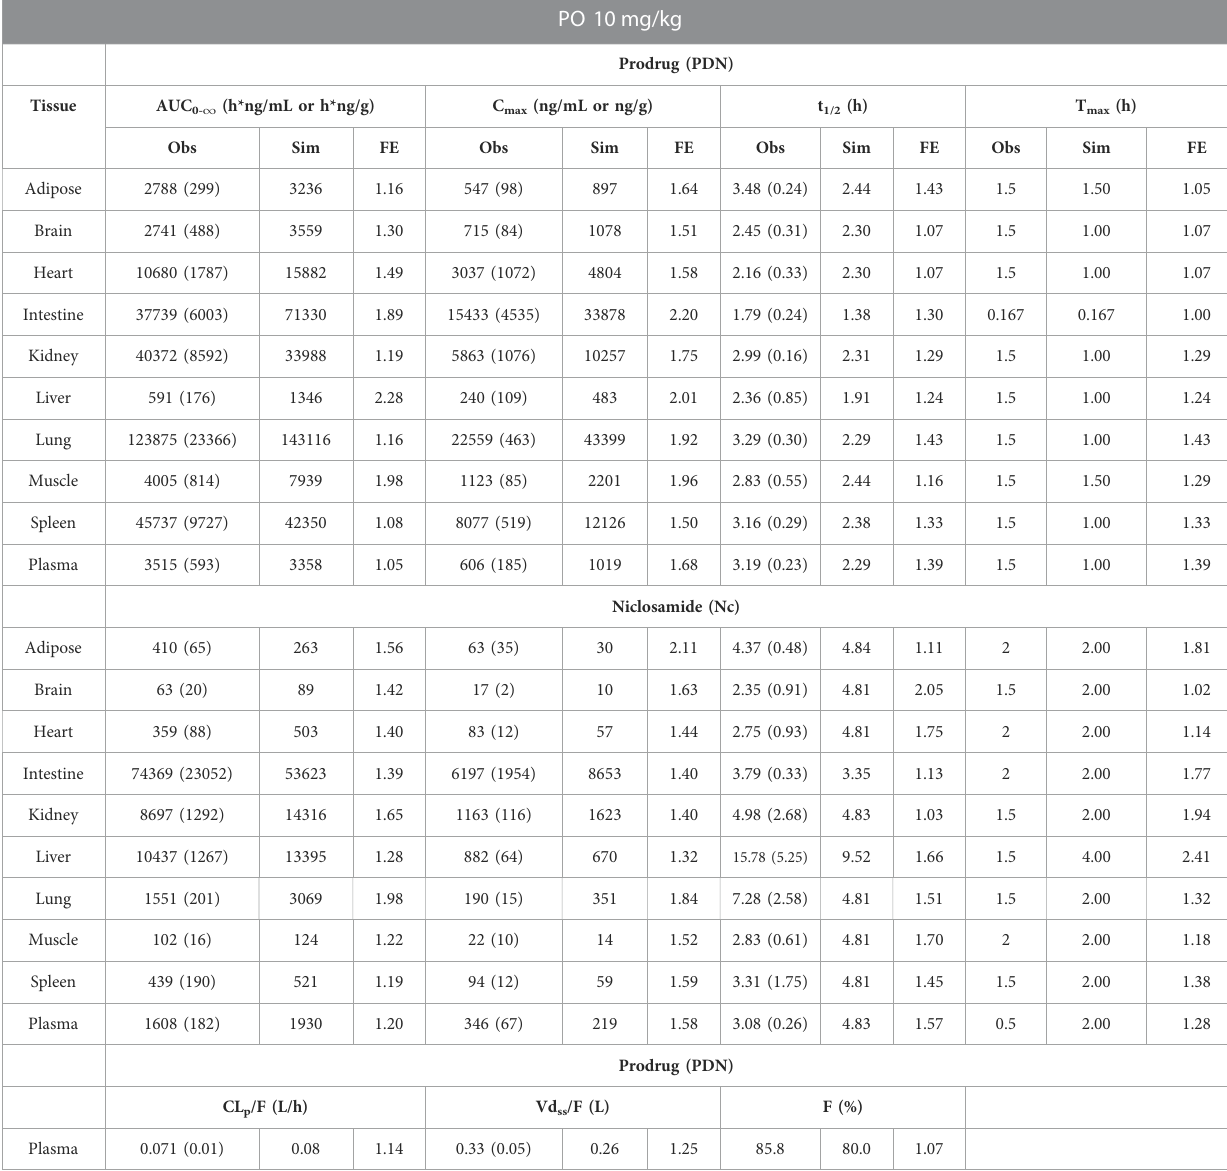
TABLE 5 Observed and simulated tissue distribution pro fi les of PDN and formed Nc after PO 10 mg/kg of PDN in mice. Data were presented as mean (SD). PO 10